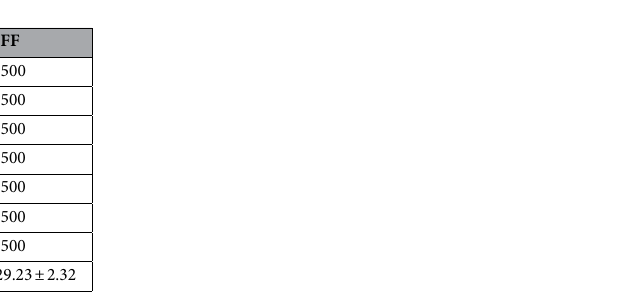
Table 2. Cytotoxicity (IC 50 ± SEM, μM) of the compounds against A375, HT29 and HFF cell lines for 48 h. No significant effect was observed on cells tested for metal